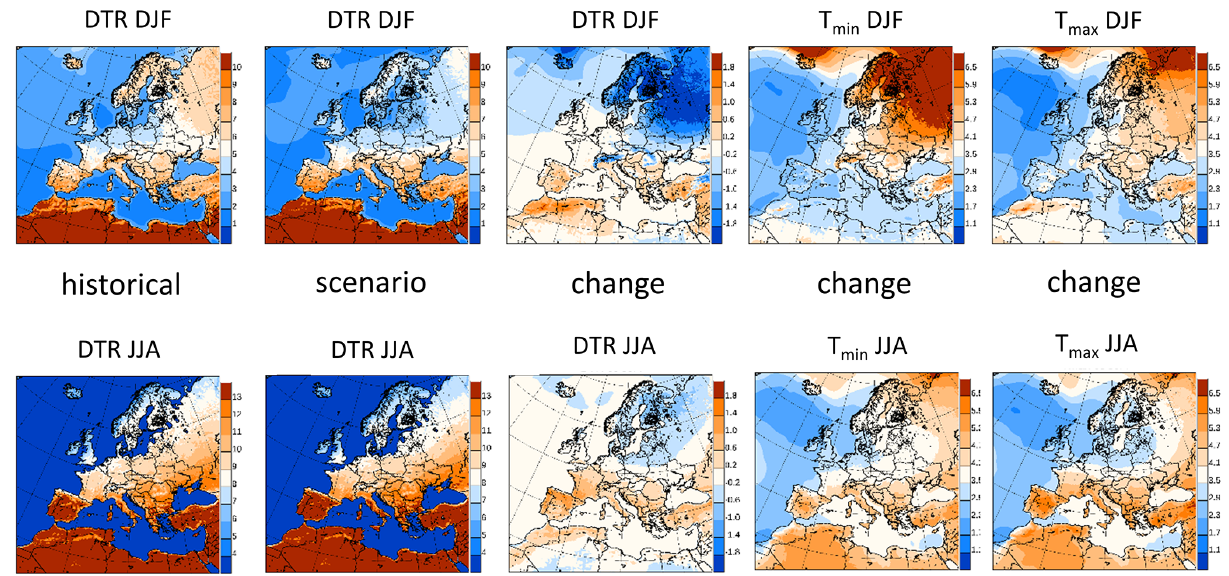
Figure 27. From left to right, daily temperature range (DTR; in degrees Celsius) during historical (1981–2010) and future (2071–2100) periods and changes in daily temperature range, daily minimum, and daily maximum temperatures in RCP8.5, according to EURO-CORDEX scenario simulations (Christensen et al., 2022). The upper and lower panels show winter (December to February – DJF) and summer (June to August – JJA) means, respectively. Data source: Earth System Grid Federation (ESGF) network, http://esgf-data.dkrz.de (last access: 5 March 2022); see Christensen et al.